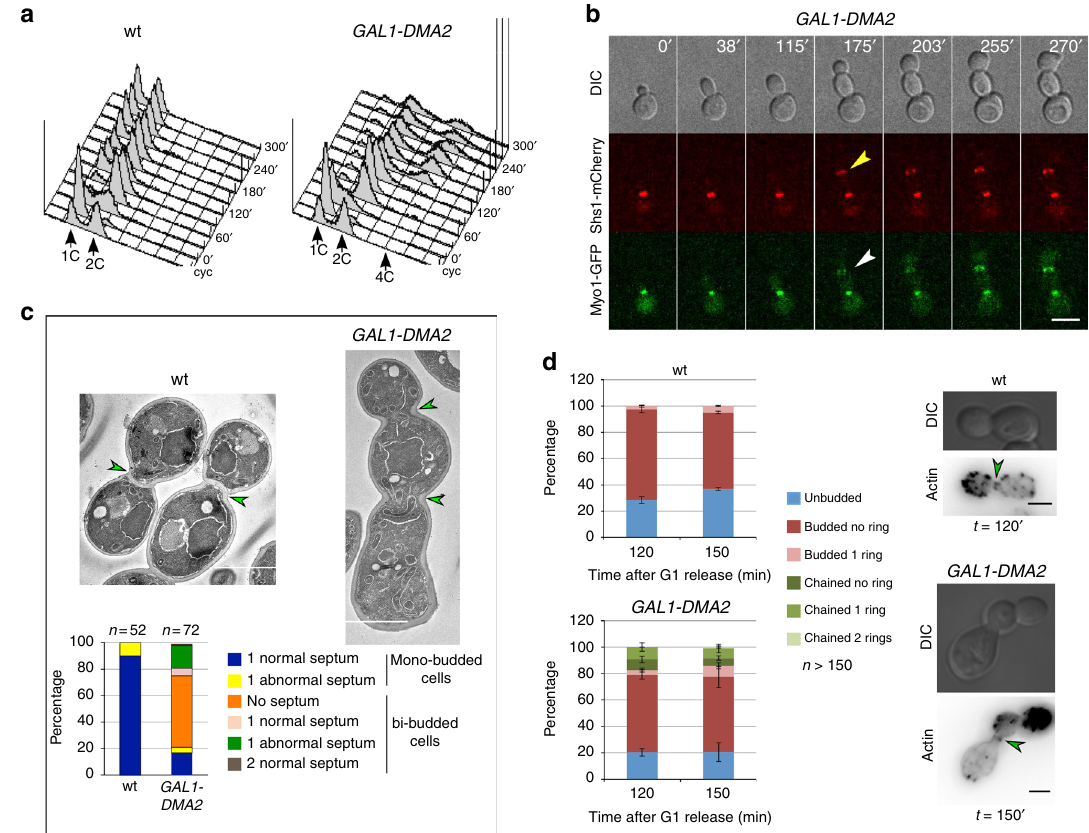
Fig. 3 Overexpression of the E3 ubiquitin ligase Dma2 prevents septin ring splitting, CAR contraction and cytokinesis. a Wild-type and GAL1-DMA2 bud4- G820fs cells were grown in YEPR at 25 °C, arrested in G1 by alpha factor and induced with 1% galactose 30 min before the release. Cells were fi nally released in YEPRG at 30 °C (time 0). Cells were collected at the indicated time points for FACS analysis of DNA contents. FACS data were plotted after gating out the debris as illustrated in Supplementary Fig. 12. b GAL1-DMA2 BUD4 cells expressing Shs1-mCherry and Myo1-GFP grown in SD-raf fi nose were induced for 90 min with galactose and then imaged in SD-raf fi nose/galactose at 30 °C. Arrowheads indicate the appearance of new septin rings (yellow) or CARs (white) before the old structures have been disassembled. DIC: differential interference contrast. Scale bar: 5 µ m. c Wild-type and GAL1-DMA2 bud4-G820fs cells were treated as in a . At 240 min after release cells were fi xed and processed for transmission electron microscopy. Scale bar: 2 µ m. d Wild-type and GAL1-DMA2 BUD4 cells were treated as in a . At the indicated times after release cells were fi xed for phalloidin staining of actin structures. Data are means from three independent experiments. Error bars: s.d. Micrographs show representative